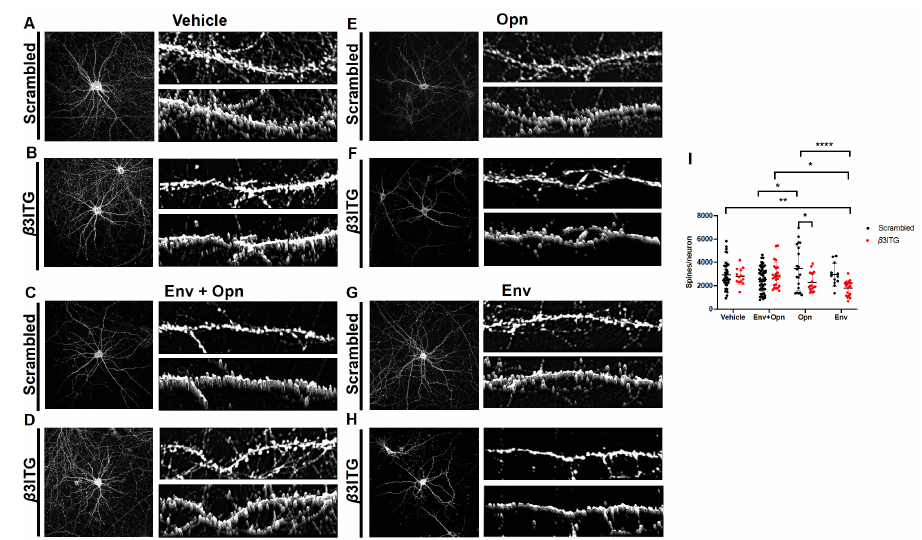
Figure 4. Opn acts via β 3 integrins to modulate spine density. Representative images of primary hippocampal neurons transfected with either scrambled siRNA ( A , C , E , G ) or β 3 integrin siRNA ( B , D , F , H ) are shown. Exogenous treatments include the following: Vehicle ( A , B ), Env + Opn ( C , D ), Opn only ( E , F ) and Env only ( G , H ). Left panel shows image of the entire neuron and on its top-right is a section of the dendrite and 3D construction of the dendrite section below it. ( I ) shows grouped interleaved scatter graph for the number of synapses per neuron due to the di ff erent treatments. The mean SD are shown with the following number of sampling for each groups: n = 5 and 117 ± neurons for vehicle treated scrambled transfected, n = 3 and 43 neurons for vehicle treated β 3